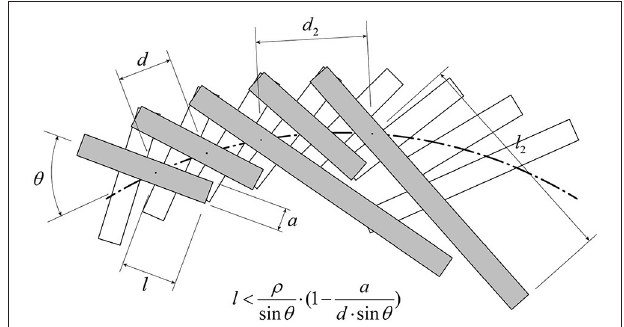
FIGURE 6 | In order to introduce gradual variation in the angles between elements, control collision between elements is established by keeping some of the in-between elements shorter (for instance the fourth white element in the figure) so that more degrees of length variation can be